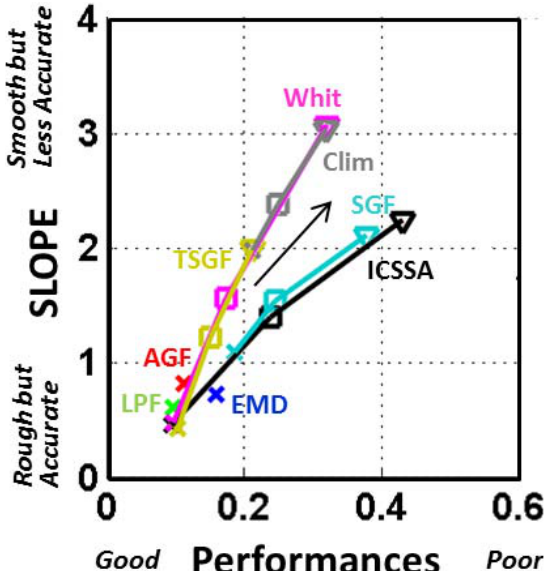
Fig. 13. Accuracy of the start of season retrieval expressed in RMSE (days) as a function of the accuracy of LAI estimated expressed in RMSE. The same colors (corresponding to methods) and markers (corresponding to classes of %gap) as in Fig. 12 are